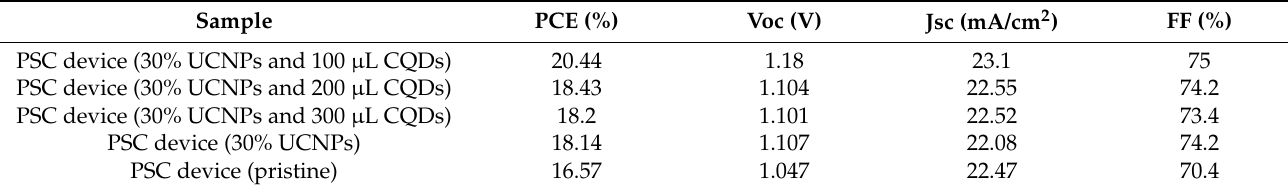
Table 1. A summary of the photovoltaic parameters of the manufactured